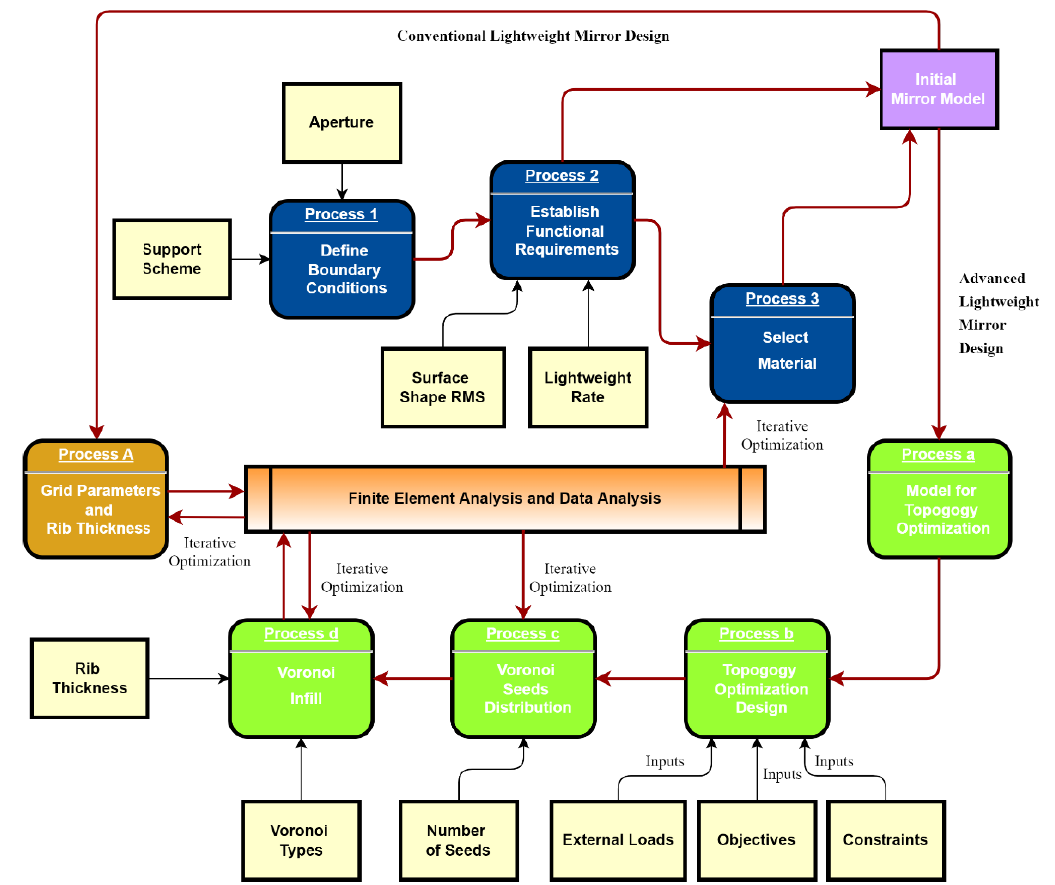
Figure 2. The design flow chart for CLM and ALM.